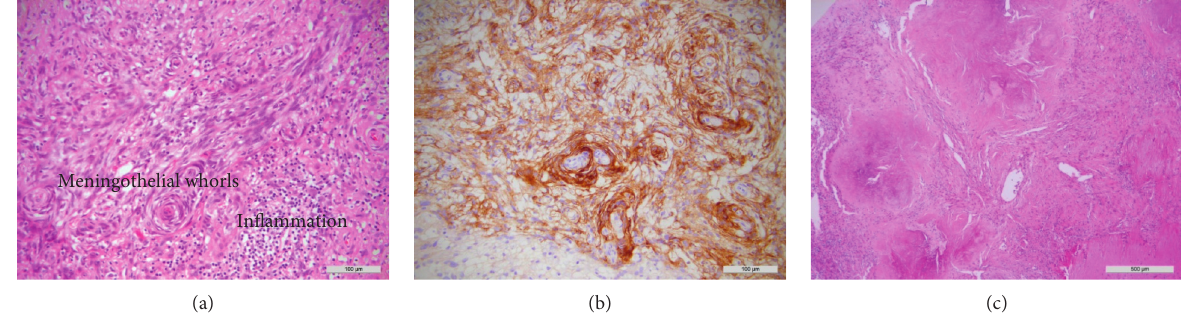
Figure 3: Histopathological examination from left frontal meningeal biopsy: (a) H&E stain demonstrating meningothelial whorls and associated chronic inflammation, (b) epithelial membrane antigen (EMA) stain confirming the meningothelial phenotype, and (c) H&E stain showing necrobiotic granulomata at the periphery of the